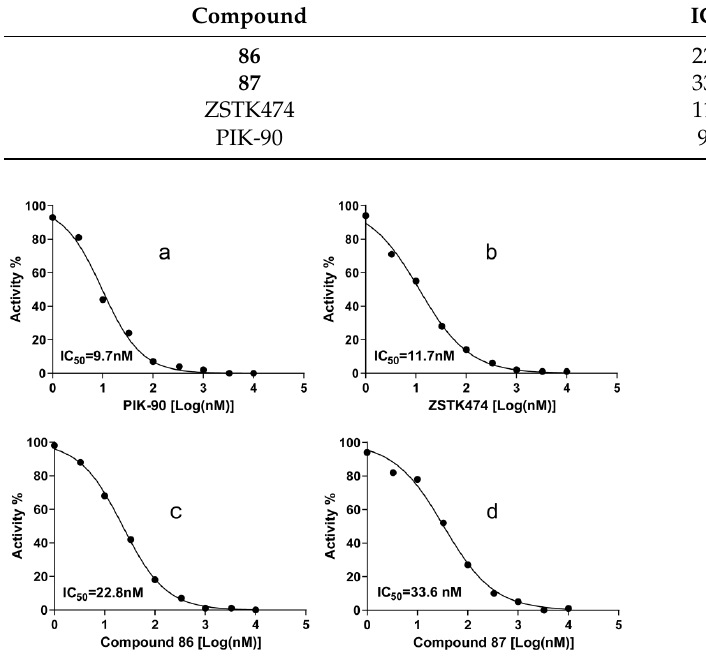
Figure 8. Dose response curves of PI3K α inhibitors PIK-90 ( a ) , ZSTK474 ( b ) , compound 86 ( c ) and Compound 87 ( d ). IC 50 values were measured with ATP as the PI3K α substrate. Each experiment was carried out in duplicate and repeated three times. Table 3. IC 50 values of compounds 86 , 87 , PIK-90, and ZSTK474 against PI3K α .